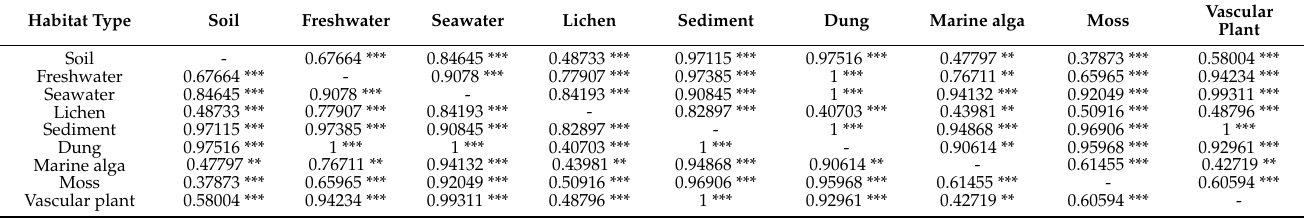
Figure 3. ( a ) NMDS ordination plot showing the spatial pattern of the mycobiome in the 114 samples from the nine habitats, ( b ) Venn diagram showing the number of ASVs in the nine habitats. Table 1. ANOSIM results for the pairwise comparisons of the similarity among the nine